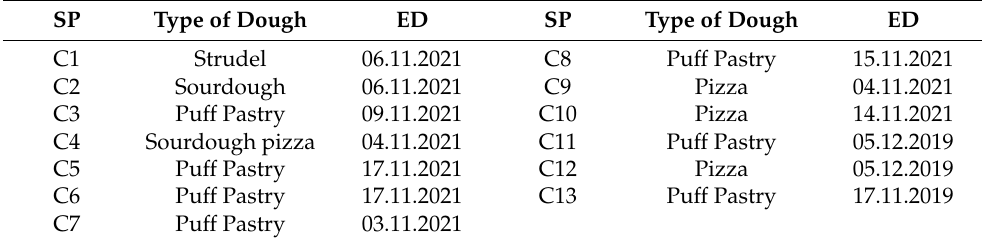
Table 2. Details and types of dough subjected for microbial